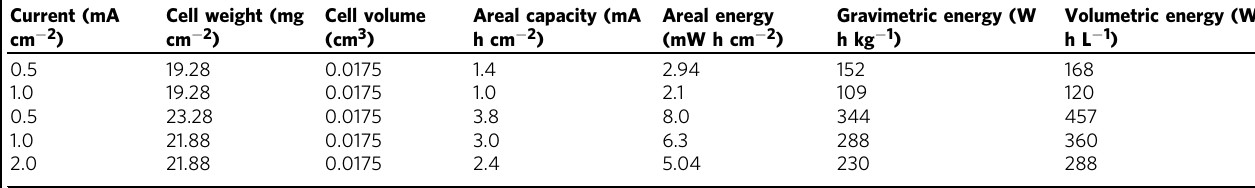
Table 1 Performance metrics of our fl exible Li-S full batteries Current (mA cm − 2